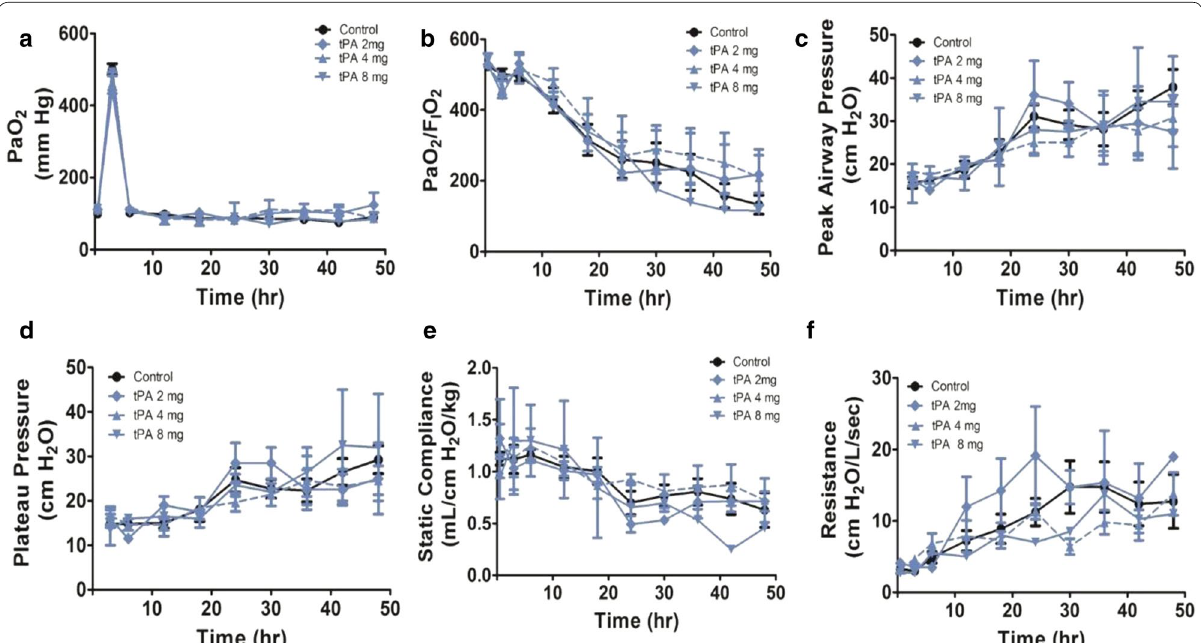
Fig. 3 Pathophysiologic effects observed in Group 2 sheep treated with nebulized tPA. Data from saline vehicle nebulized controls (n two animals that succumbed prematurely, prior to 48 h) or animals nebulized with tPA at the 2 mg dose according to the schedule illustrated in Fig. 1 (n 2) or at the 4 mg/unit dose (n 6, including one animal that succumbed prematurely) or at 8 mg (n = = (mm Hg). b PaO 2 /FiO 2 ratios. c Peak airway pressures (cmH 2 O). d Plateau airway pressures (cmH 2 O). e Static lung compliance (mL/cmH 2 O/kg). f Lung resistance (L/cmH 2 O/min). Although all the above trend over time were statistically significant (p < 0.001) there were no statistically significant intergroup